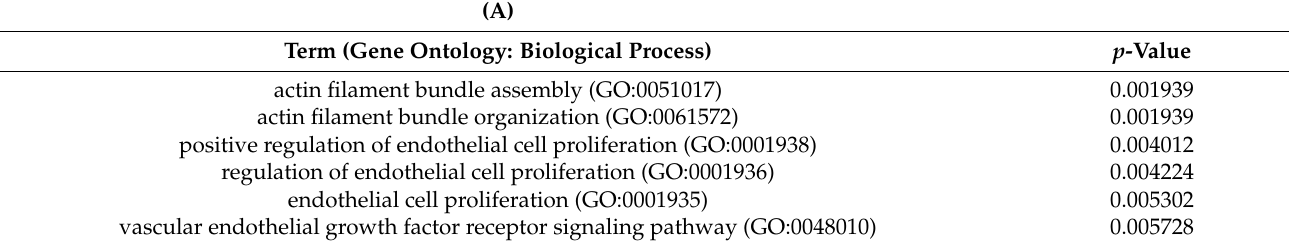
Table 5. Enrichment analysis of transcriptomic data after DPP4 siRNA and LPS ( DPP4 siRNA/LPS vs. negative control/LPS). ( A ) Gene ontology (biological process): DPP4 siRNA/LPS vs. negative control/LPS. ( B ) KEGG pathway: DPP4 siRNA/ LPS vs. negative control/